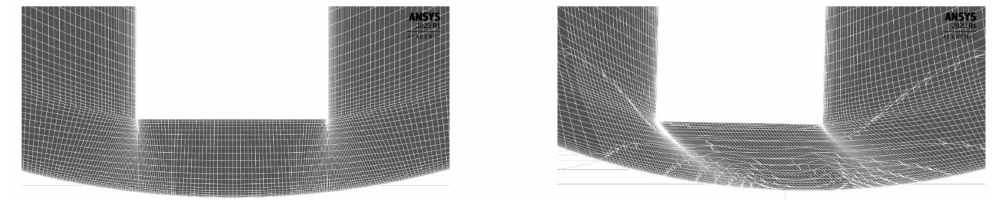
Figure 19. ( Left ): undeformed mesh near thermowell tip. ( Right ): morphed mesh near thermowell tip [61].